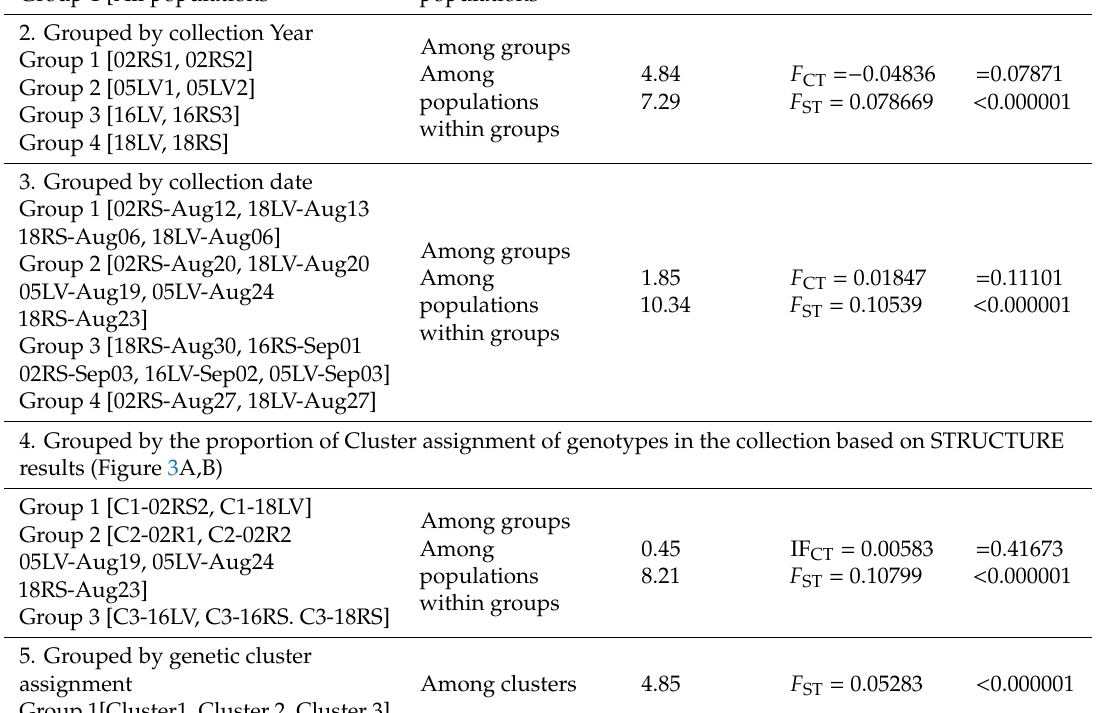
% Total Φ Variance